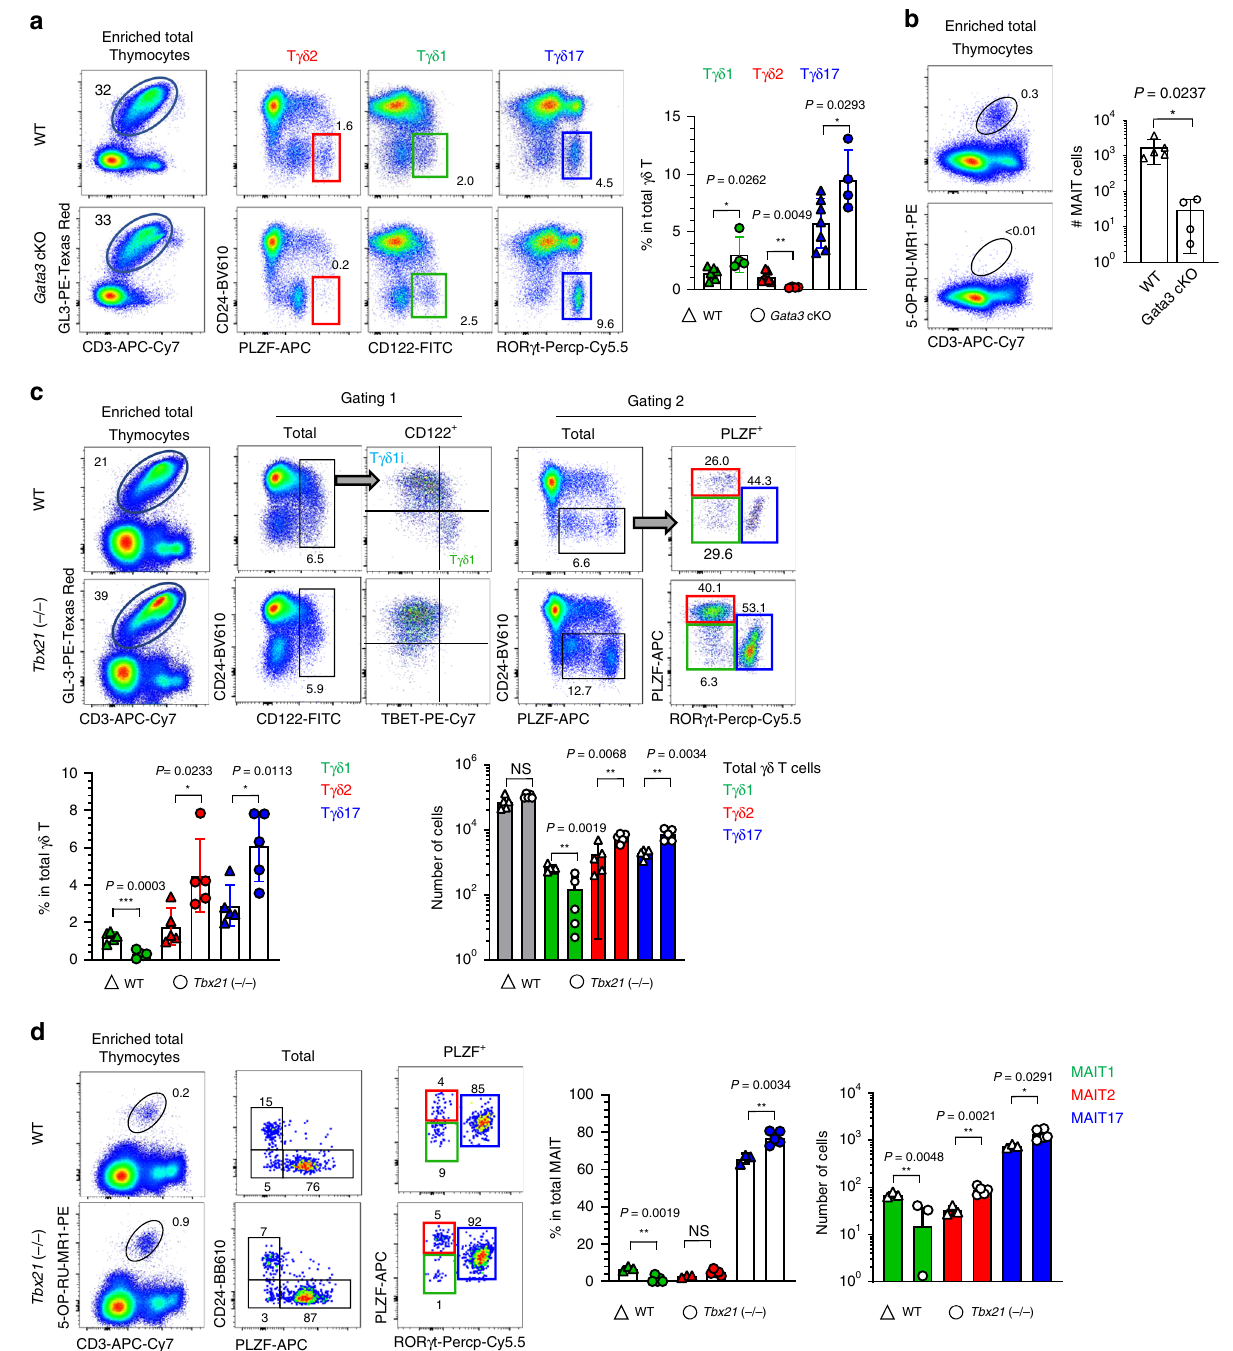
Fig. 6 γδ T and MAIT cells develop via lineage differentiation process. a Thymocytes from Cd4 Cre (WT, n = 7) or Cd4 Cre Gata3 f/f (conditional KO (cKO), n = 4) mice were enriched for γδ T cells using MACS beads and analyzed for their subset frequencies amongst total γδ T cells (left). Graph shows statistical analysis (right). Representative data of two independent sets of experiment are shown. b MAIT cells were enriched from total thymocytes of WT ( n = 5) or Gata3 cKO ( n = 4) mice and compared for their absolute numbers. Representative dot plots (left) and statistical comparison is shown (right). Representative results from two independent sets of experiments are shown. c , d Single-cell suspensions of thymocytes from WT ( n = 5) or TBET-de fi cient mice ( n = 5) were enriched for γδ T ( c ) and MAIT ( d ) cells using MACS beads and analyzed for their subset development. Representative dot plots are from three independent experiments (left) and graph shows statistical analysis of three independent sets of experiment (right). Numbers indicate frequencies of cells in adjacent gates. Data are presented as mean ± SD. Unpaired two-tailed t -test was used. * P < 0.05, ** P < 0.01, *** P < 0.001. NS not signi fi cant ( P > 0.05). Source data are provided as a Source Data fi